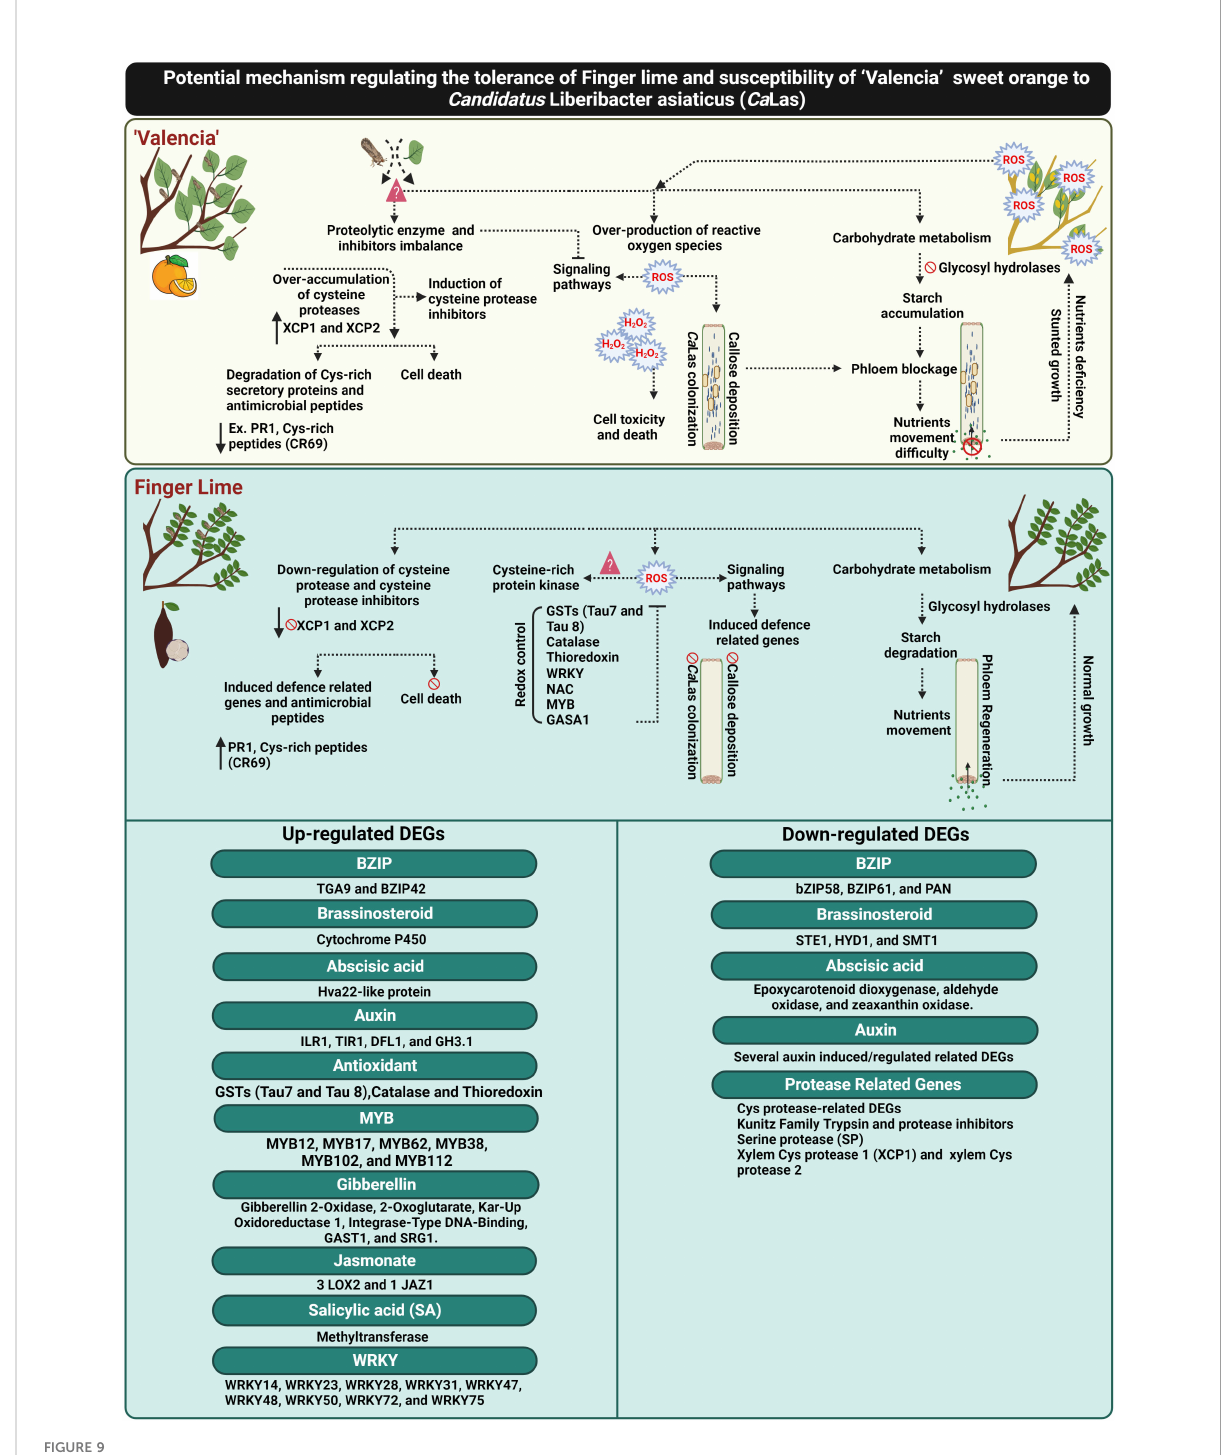
FIGURE 9 Schematic diagram elucidating the potential mechanism of Ca Las tolerance in the Finger lime, and susceptibility in ‘ Valencia ’ sweet orange. The fi gure was created in